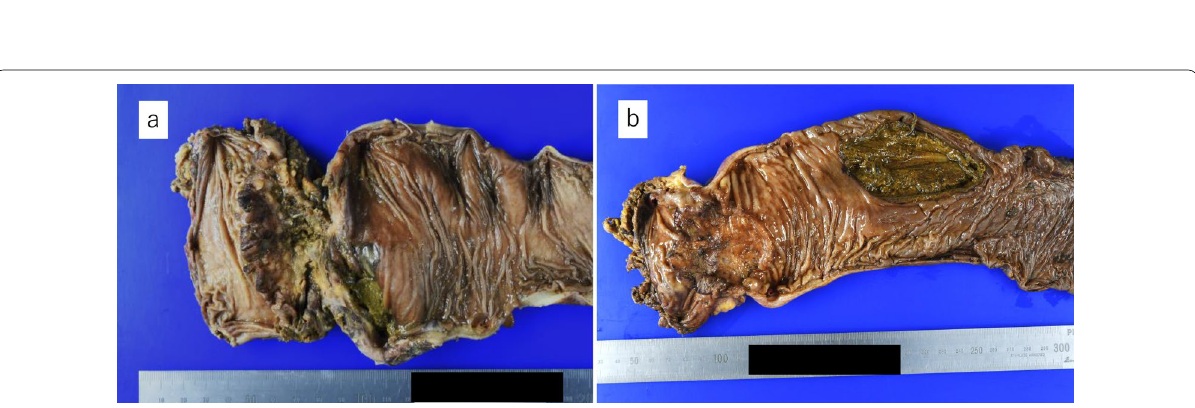
Fig. 3 Resected specimen. a Case 1: pathological findings were 90 margin of 28 mm. b Case 2: pathological findings were 65 20 mm. A perforation was observed in the rectal sigmoid colon away from the